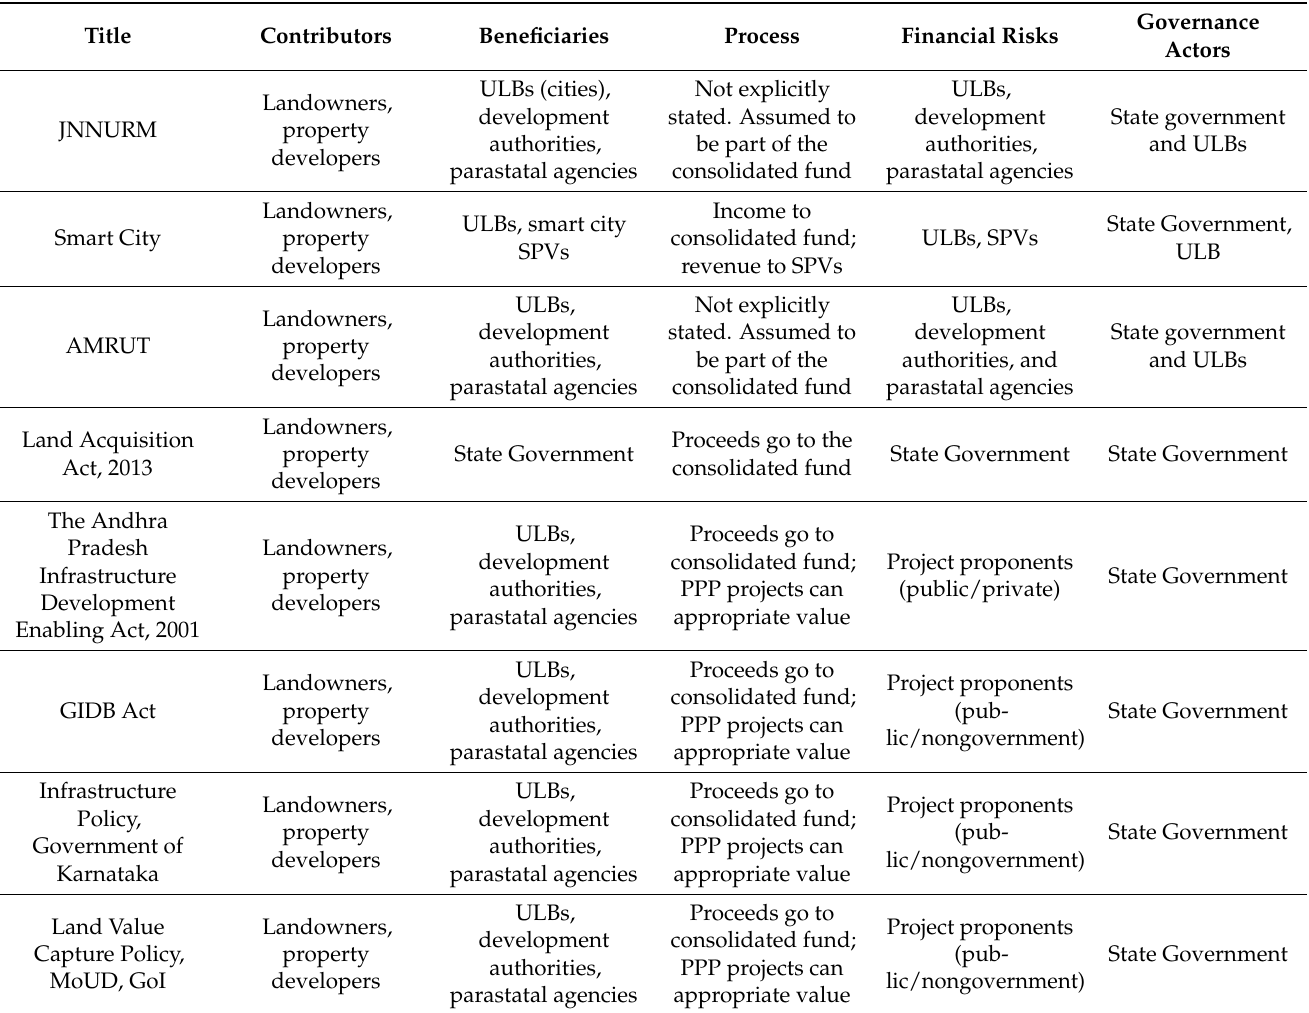
Table 4. Comparative Analysis of